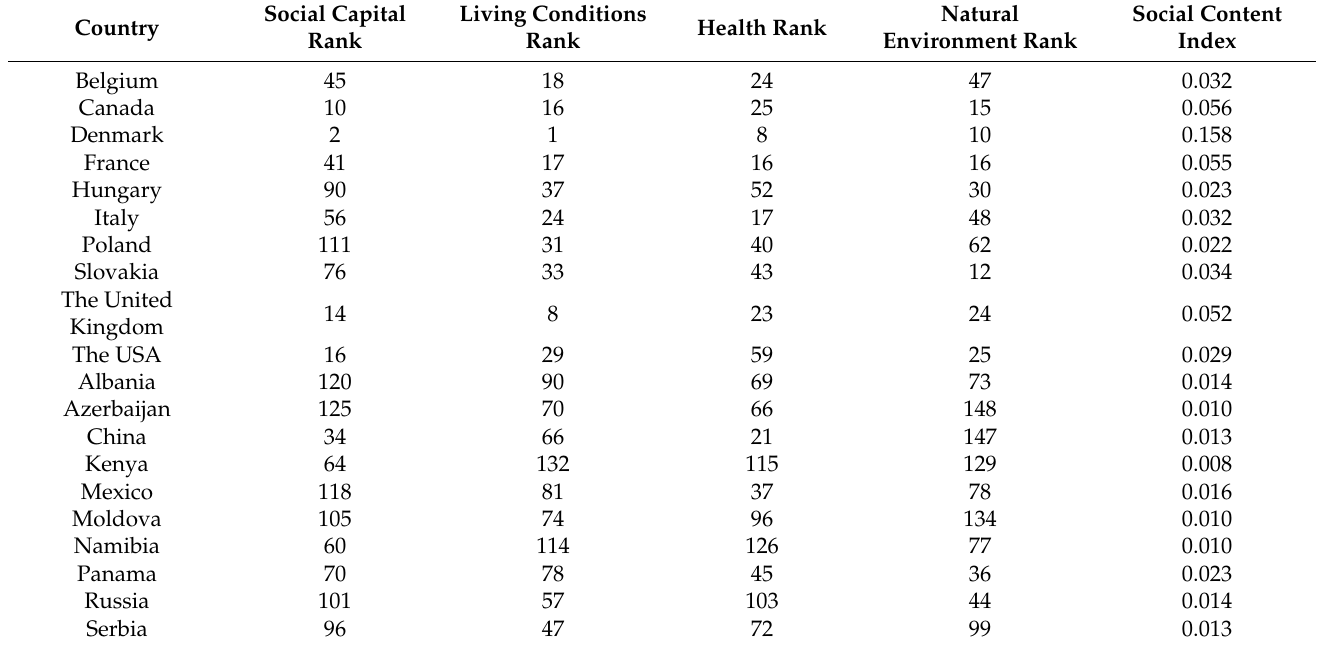
Table 3. Initial data for determining the Social Content Index of the studied